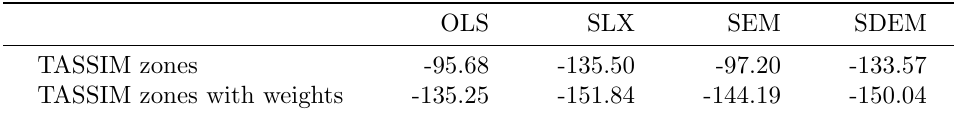
Table A.5: Model AIC values for observations on 96 approximate TASSIM